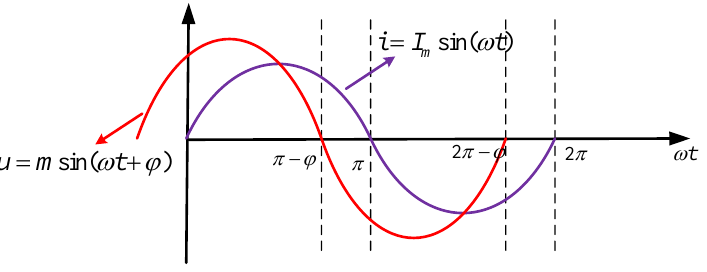
Figure 5. The principle of SPWM.